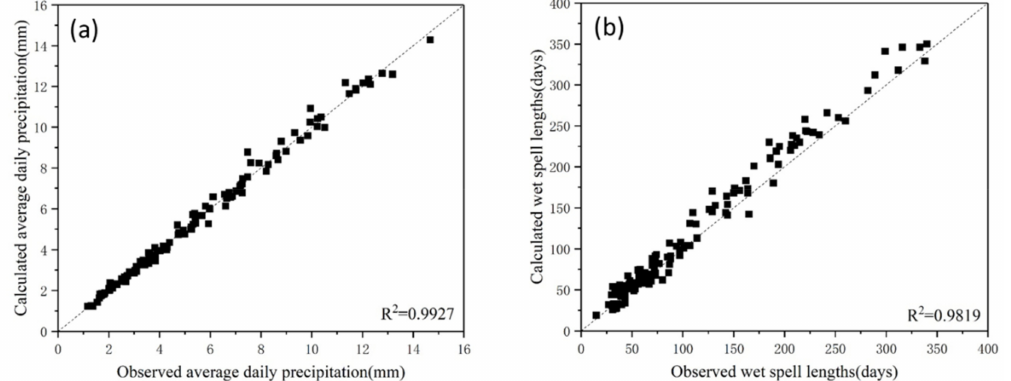
Figure3. Comparison, intermsofaveragedailyprecipitationonwetdaysandwetspelllengths, between statistical values of the observed data and the CLIGEN-generated data without using shu ffl e procedure (pre-shu ffl ed data) in the Huangfuchuan Basin. The historical period is 1976–2005. ( a ) average daily precipitation on wet days; ( b ) wet spell